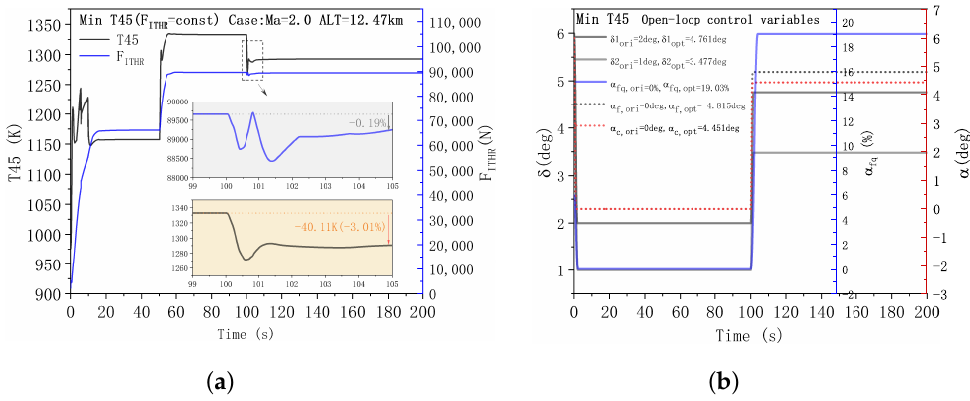
Figure 15. ( a ) Simulation analysis of incorporating PSC Min T45 module and ADRC controller. ( b ) Dynamic analysis of the open-loop controlled variables α fq , δ 1 , δ 2 , A 8 , α f , α c under Min T45 mode.